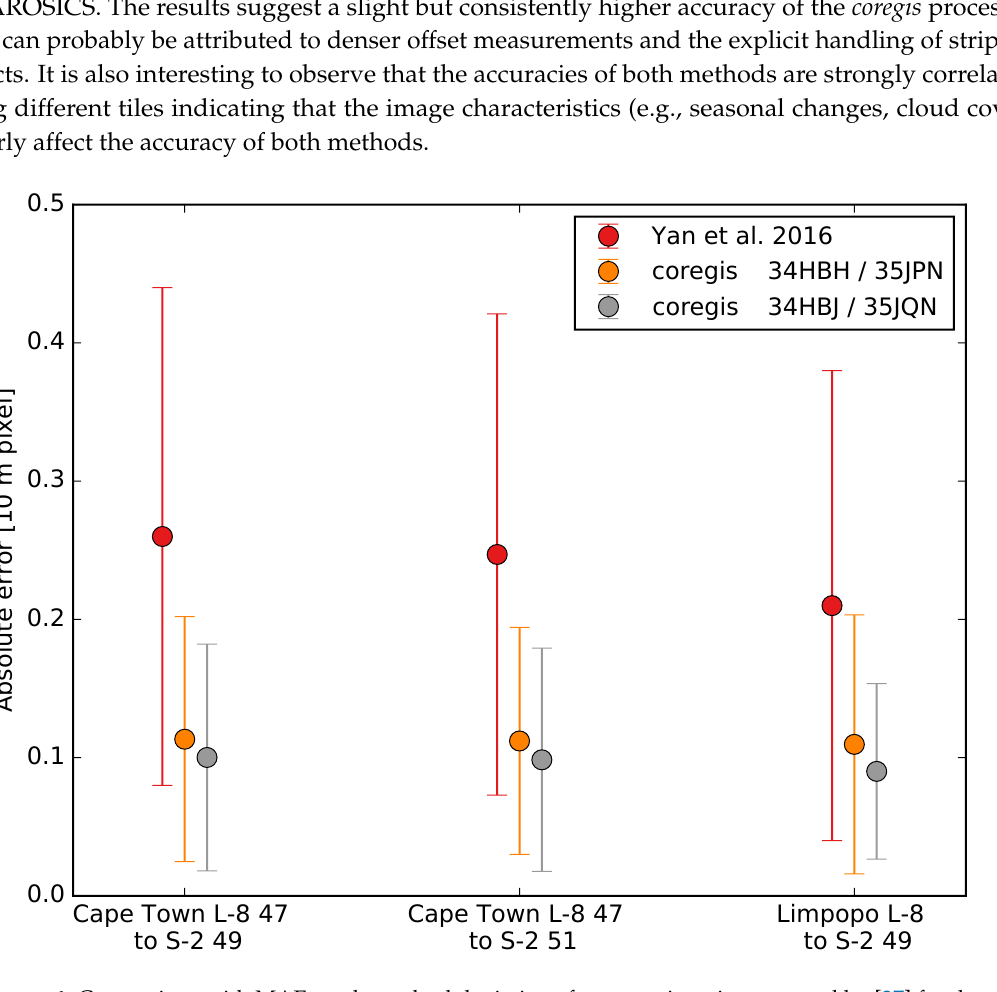
Figure 4. Comparison with MAEs and standard deviation after co-registration reported by [27] for the South Africa test site. (note, L-8: Landsat-8; S-2: